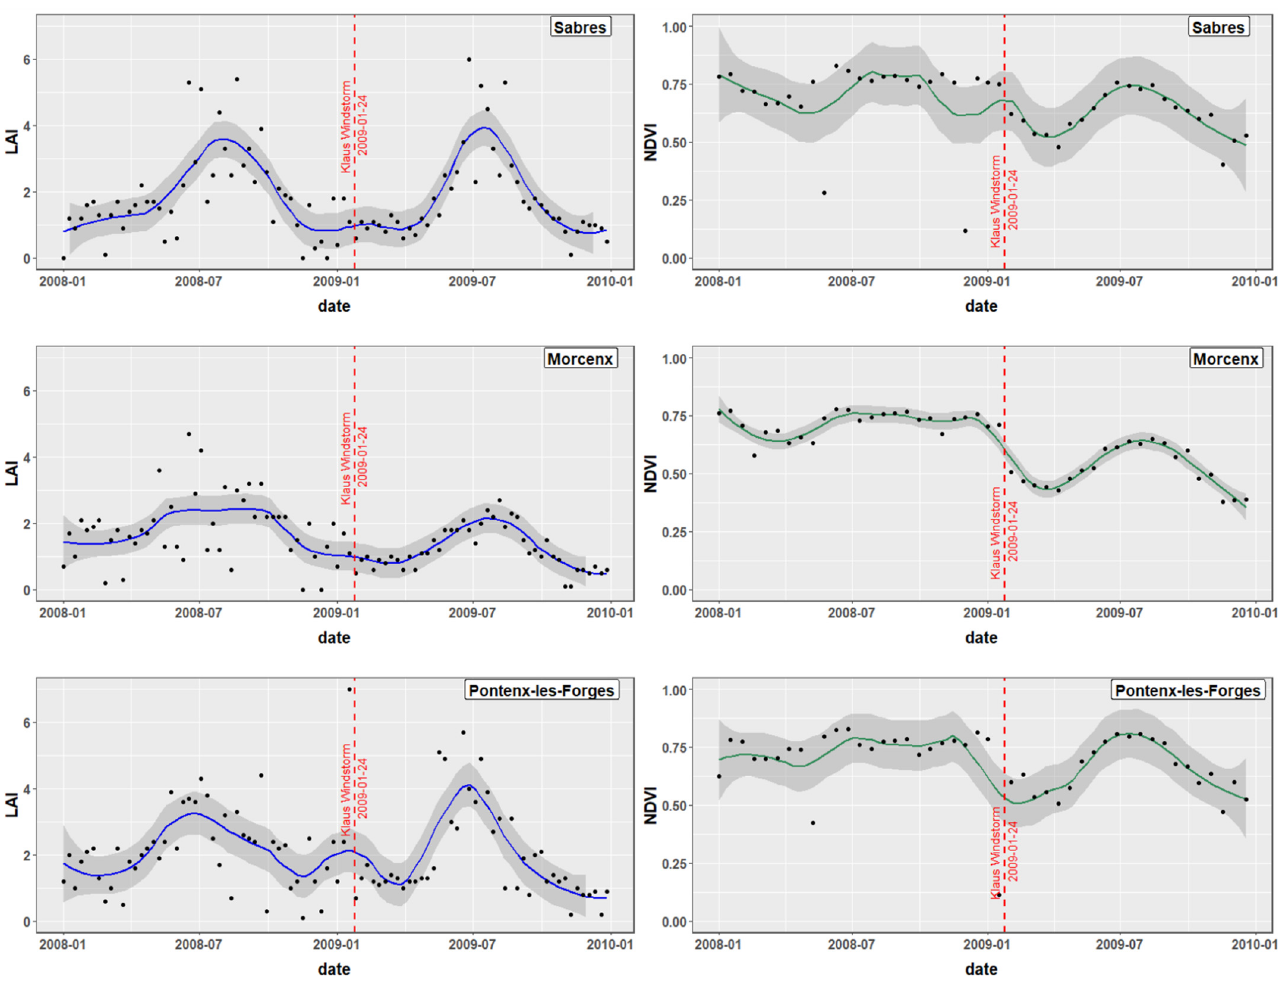
Figure 2. Timeseries of MODIS-based NDVI and LAI showing the negative impact of windstorm Klaus. The timeseries are for three localities shown in Figure 1 with a damage degree ≥ 0.9. Authors’ own compilation based on the MODIS web service (https://modis.ornl.gov/data/modis_webservice.html; accessed on 1 October 2022). The data was imported using the MODISTools 1.1.2 R package [37].